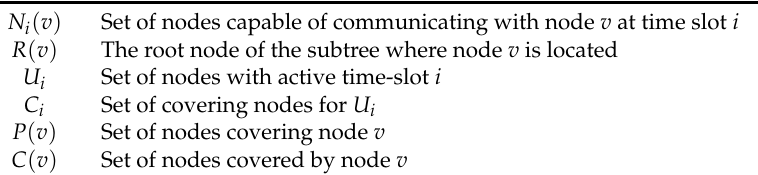
Table 3. Notations.